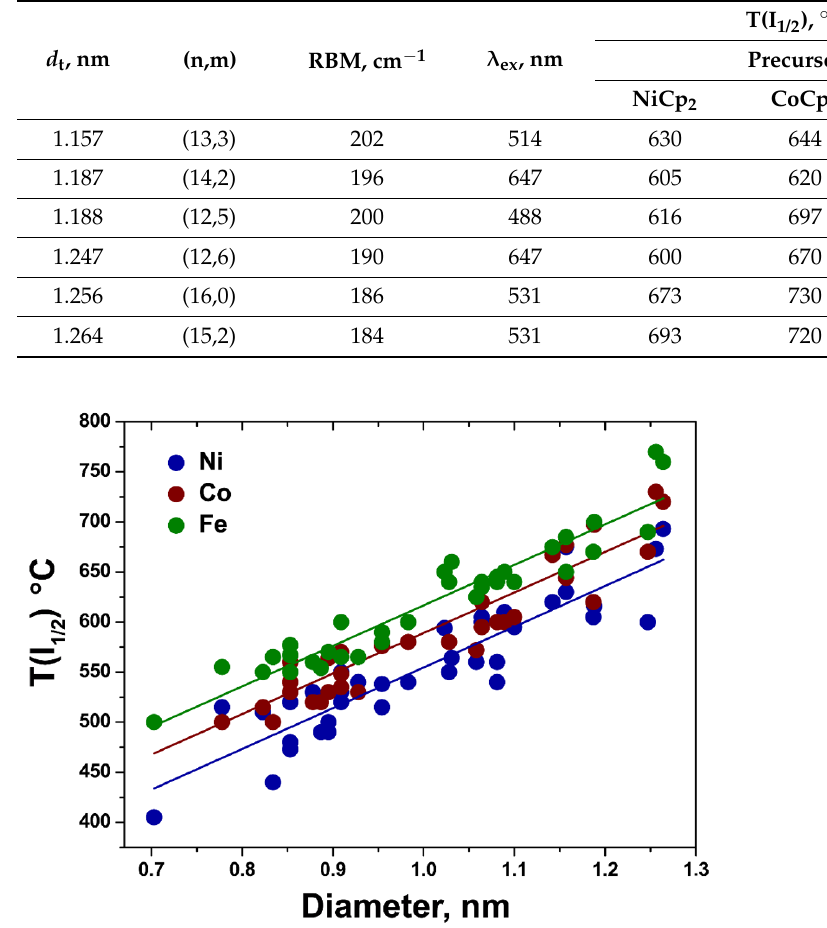
Figure 6. T(I 1/2 ) plotted against the tube diameter for the tubes grown inside the annealed NiCp 2 -, CoCp 2 - and FeCp 2 -filled SWCNTs, observed in the Raman spectra acquired at laser wavelengths between 458 and 1064 nm. The linear fits of the experimental data (filled circles) are shown as solid lines. Table 1. The diameters ( d t ), chiral indexes (n, m), RBM peak positions, excitation laser wavelengths ( λ ex ) and evaluated T(I 1/2 ) growth temperatures of the inner tubes observed in the Raman spectra of the annealed NiCp 2 -, CoCp 2 - and FeCp 2 -filled SWCNTs.